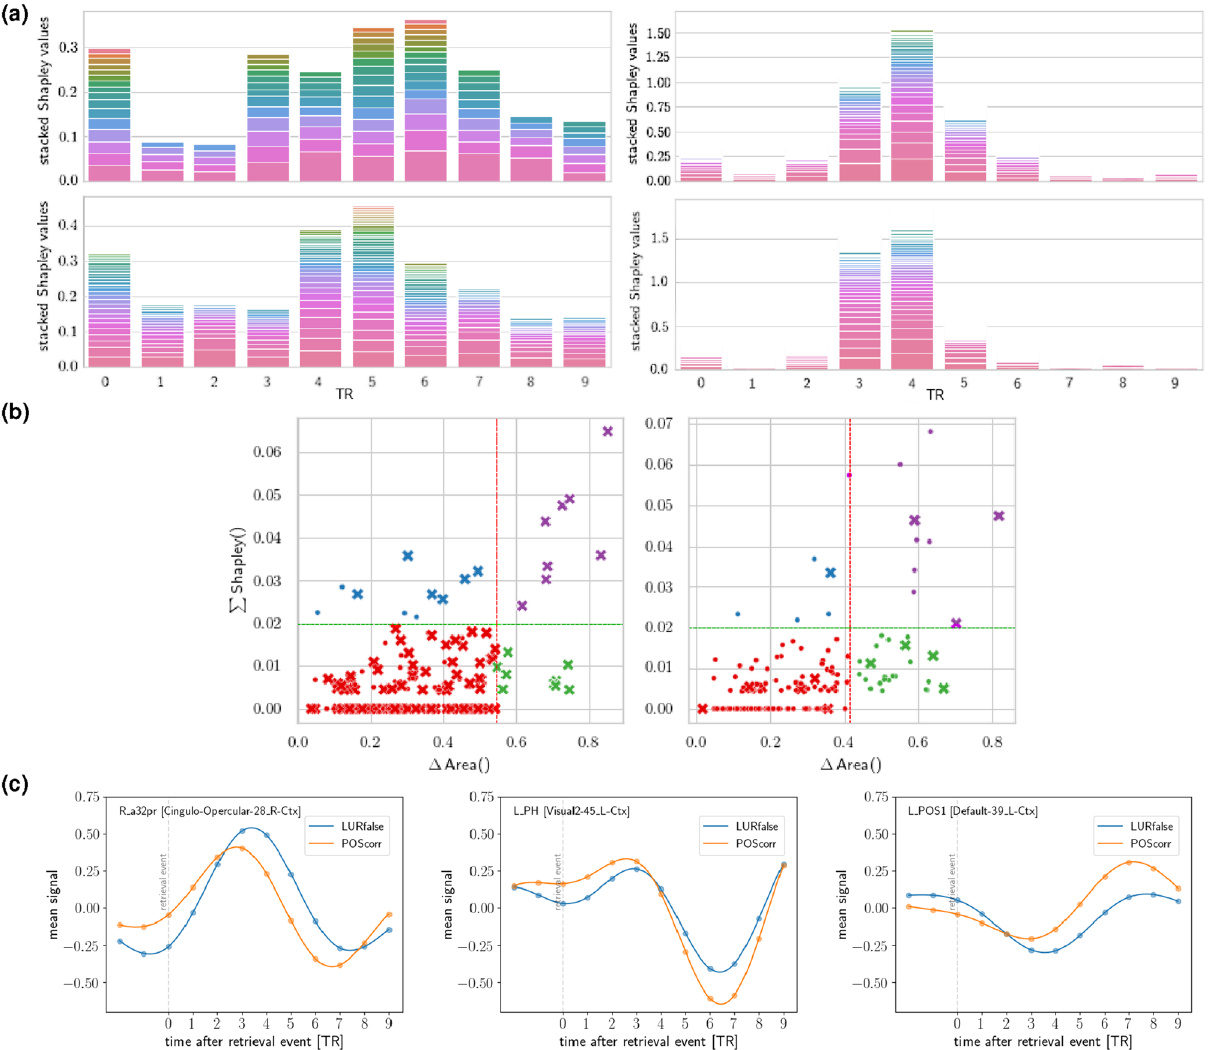
Figure 5. Results of Shapley analysis. ( a ) Stacked histograms show the regions used in the best gradient boosting models, weighted by their Shapley values for each TR on the horizontal axis. For each TR, a stack is composed of bars that correspond to relevant regions. The vertical width of each bar corresponds to that region’s Shapley relative value, and are sorted from the most relevant at the bottom. AAL (top) and MMP/CA parcellations (bottom row) for the POScorr–LURfalse (left) and NEGcorr–LURcorr (right column) problems are given. Histograms show that the same TRs are most relevant irrespective of brain parcellation method and surface/volume registration used. ( b ) The Shapley sum vs (cid:31) Area values for POScorr–LURfalse (left) and NEGcorr–LURcorr (right plot) problems and the 0–4 (inclusive) TR time windows. Red vertical and green horizontal lines denote critical values for the (cid:31) Area Shapley sums, respectively. Dot and cross marks denote individual regions. Crosses represent regions where local maxima of mean activations for both measures occur. Colors are introduced for readability to denote different critical values quadrants. ( c ) Mean signals temporally locked to the retrieval event for POScorr–LURfalse for region with the highest Shapley sum in the early time window 0–5 TR (left) and regions with the 1st and 4th the highest Shapley sums in the late time window 5–9 TR (centre and right). The relevance of the latter two regions for the ML classifier in the late time window comes from two qualitatively different types of